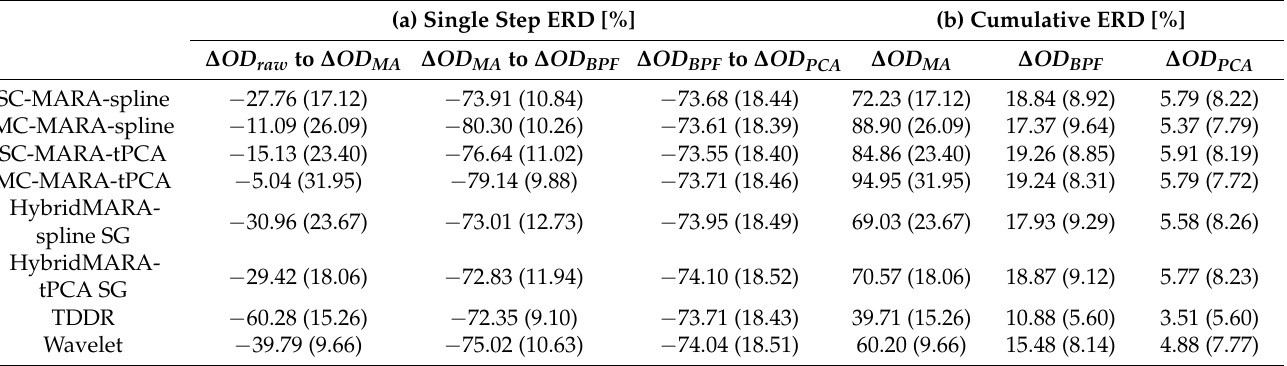
Table 2. Summary table of the percentage Energy Relative Decrease (ERD) over optical density data along the pre-processing pipeline. Values are reported as mean (std) values across subjects and channels. ( a ) Progressive ERD at the single pre-processing step: unprocessed optical density ( ∆ OD raw ), after MA removal ( ∆ OD MA ), after BPF ( ∆ OD BPF ) and finally after PCA ( ∆ OD PCA ) as the final step of the processing pipeline. ( b ) Cumulative ERD with respect to the unprocessed optical density value (i.e., cumulative ERD =